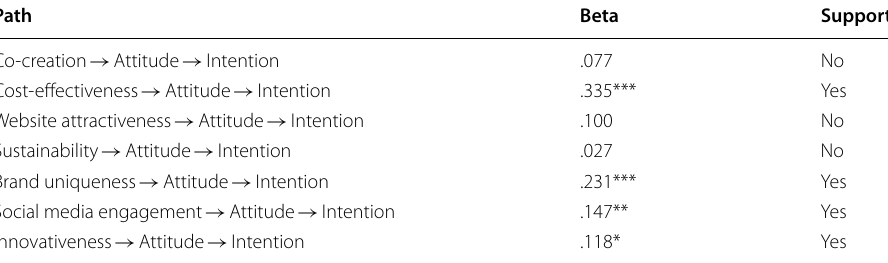
Table 6 Results of the indirect